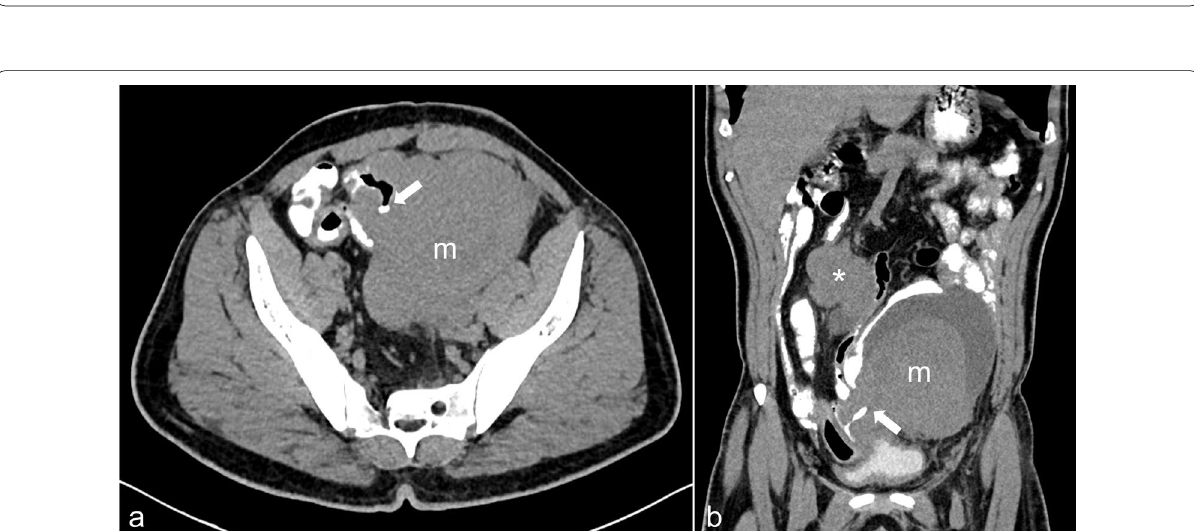
Fig. 2 Non contrast computed tomography (NCCT) axial a and coronal b images with positive oral contrast showing a mass (m) in left lower abdomen with evidence of fistulous communication (white arrow) with the adjacent ileal loop. Another similar density lesion (asterisk) is noted